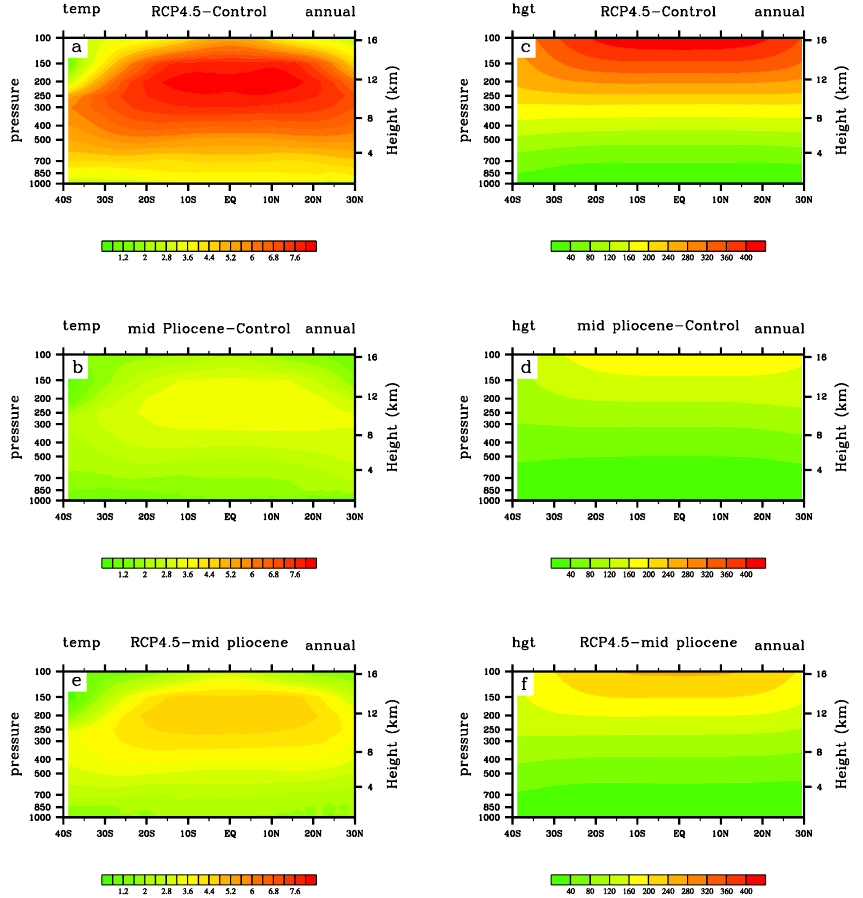
Fig. 6. Zonal average air temperature anomalies (units: ◦ C) (a) between RCP4.5 and control run, (b) between mid-Pliocene and control Fig. 6 Zonal average air temperature anomalies (units: ºC) (a) between RCP4.5 and 2 run. Potential height changes (units: m) (c) between RCP4.5 and control run, and (d) between mid-Pliocene and control run. Zonal average anomalies of air temperature (e) and potential height (f) between RCP4.5 and control run, (b) between mid-Pliocene and control run. Potential height changes (units: 3 m) (c) between RCP4.5 and control run, (d) between mid-Pliocene and control run. 4 Zonal average anomalies air temperature (e) and potential height (f) between RCP4.5 5 and mid-Pliocene. 6